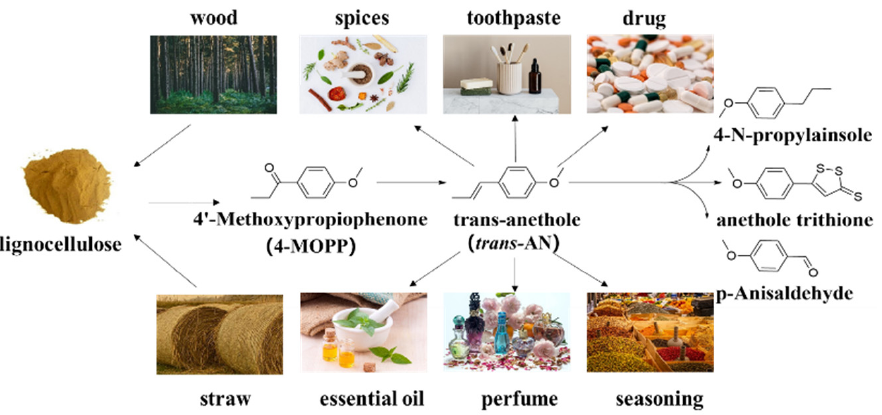
Figure 1. Production and application of trans- AN.